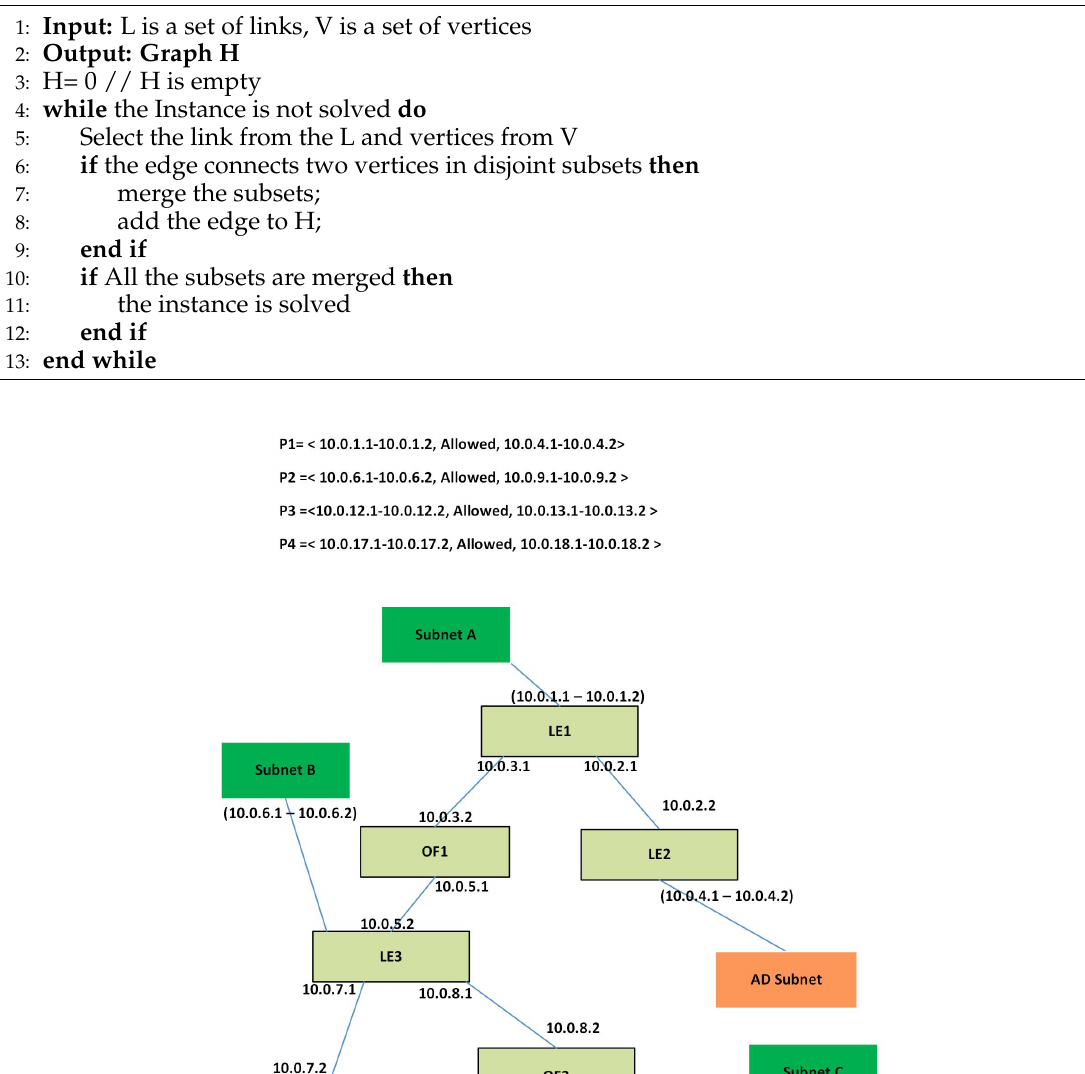
Algorithm 1 Decision Tree Construction